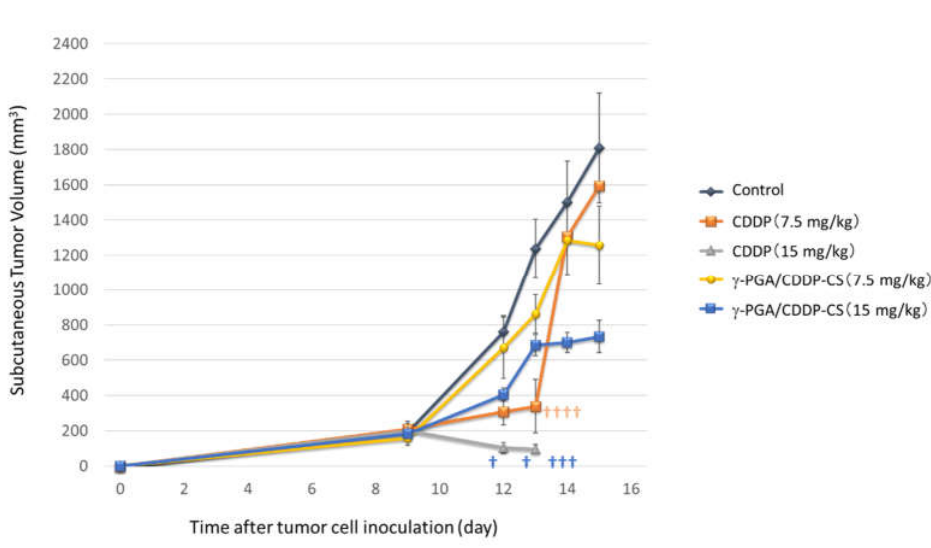
Figure 6. In vivo antitumor effect. AB23G2 cells were inoculated on the backs of mice. Each compound was administered 9 days after inoculation. In the CDDP high−dose (15 mg/kg) group ( ▲ ), all mice died within 14 days of inoculation and 5 days after administration. In the CDDP low−dose (7.5 mg/kg) group ( ■ ), 4 out of 5 died in 14 days. In the γ−PGA/CDDP−CS group (high−dose [ ■ ], low−dose [●]), tumor growth was suppressed on Days 13, 14, and 15. In the control group ( ◆ ), consistent tumor growth was observed. The † in the figure indicates that the mouse died. Data are represented as mean values ± standard error of the mean (SEM).